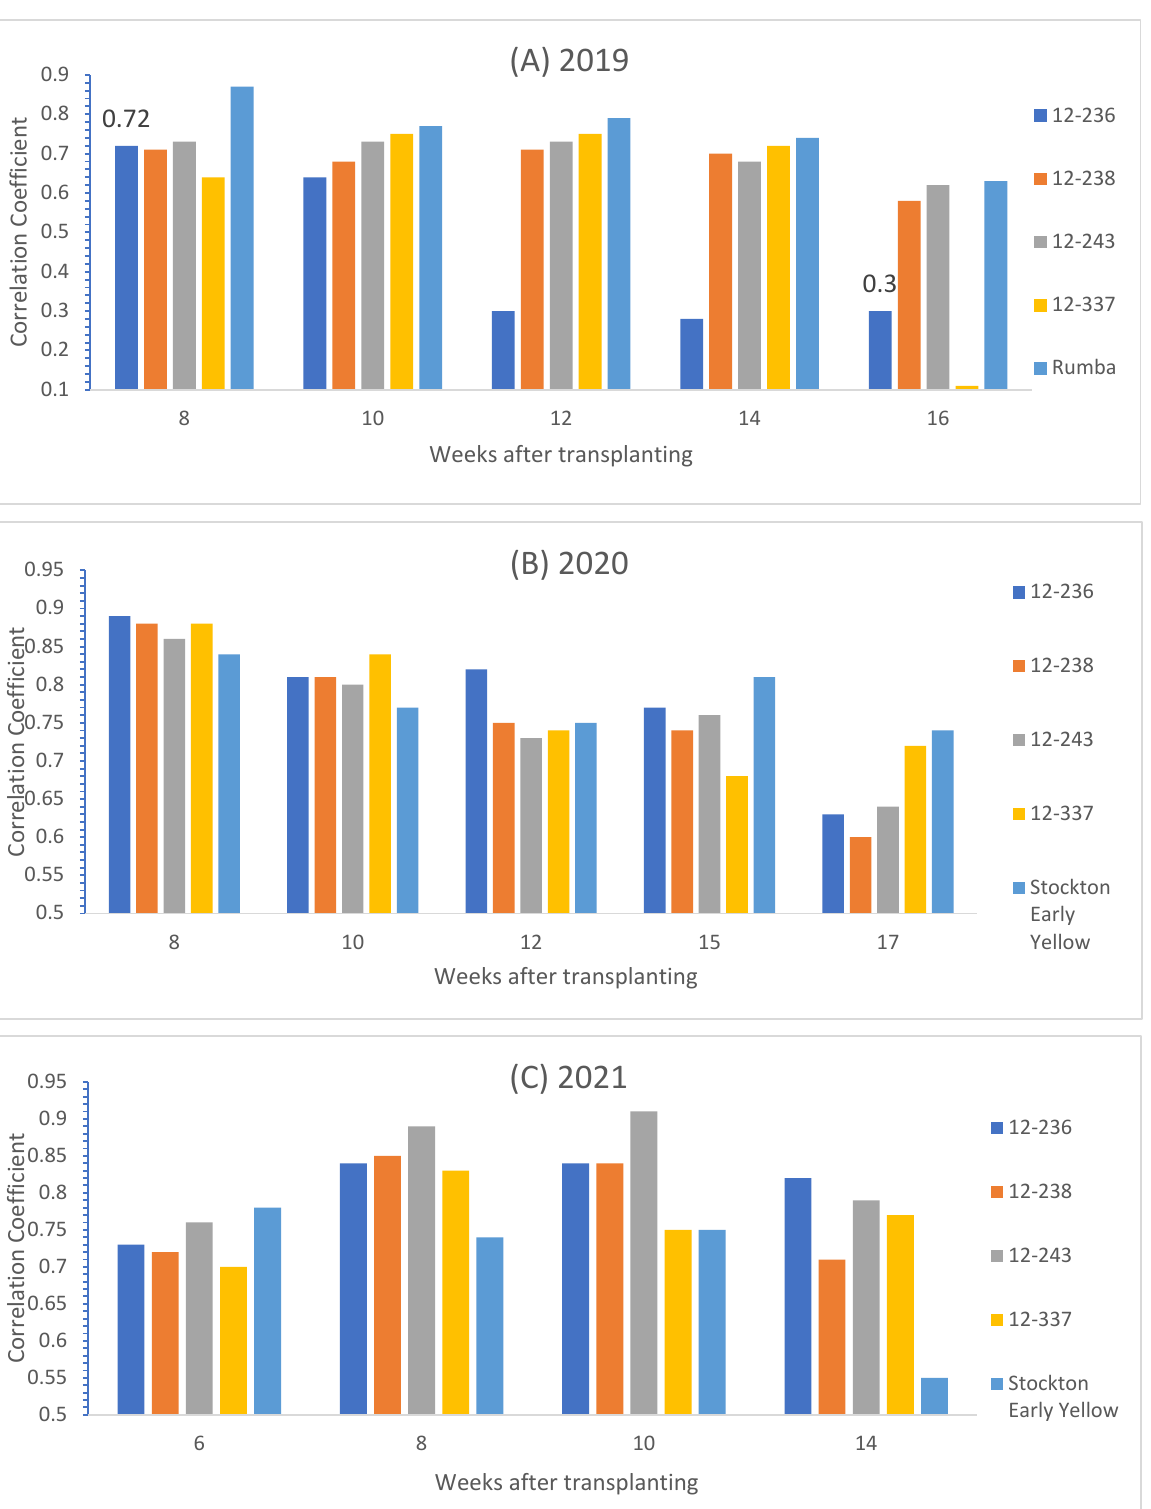
Figure 1. Correlations between sheath diameter and leaf number through the growing season and for entries on a per plant basis in ( A ) 2019, ( B ) 2020 and ( C ) 2021, at p < 0.001 significance level.